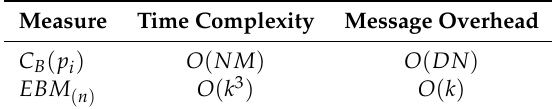
Table 2. Complexity comparison between sociocentric and egocentric